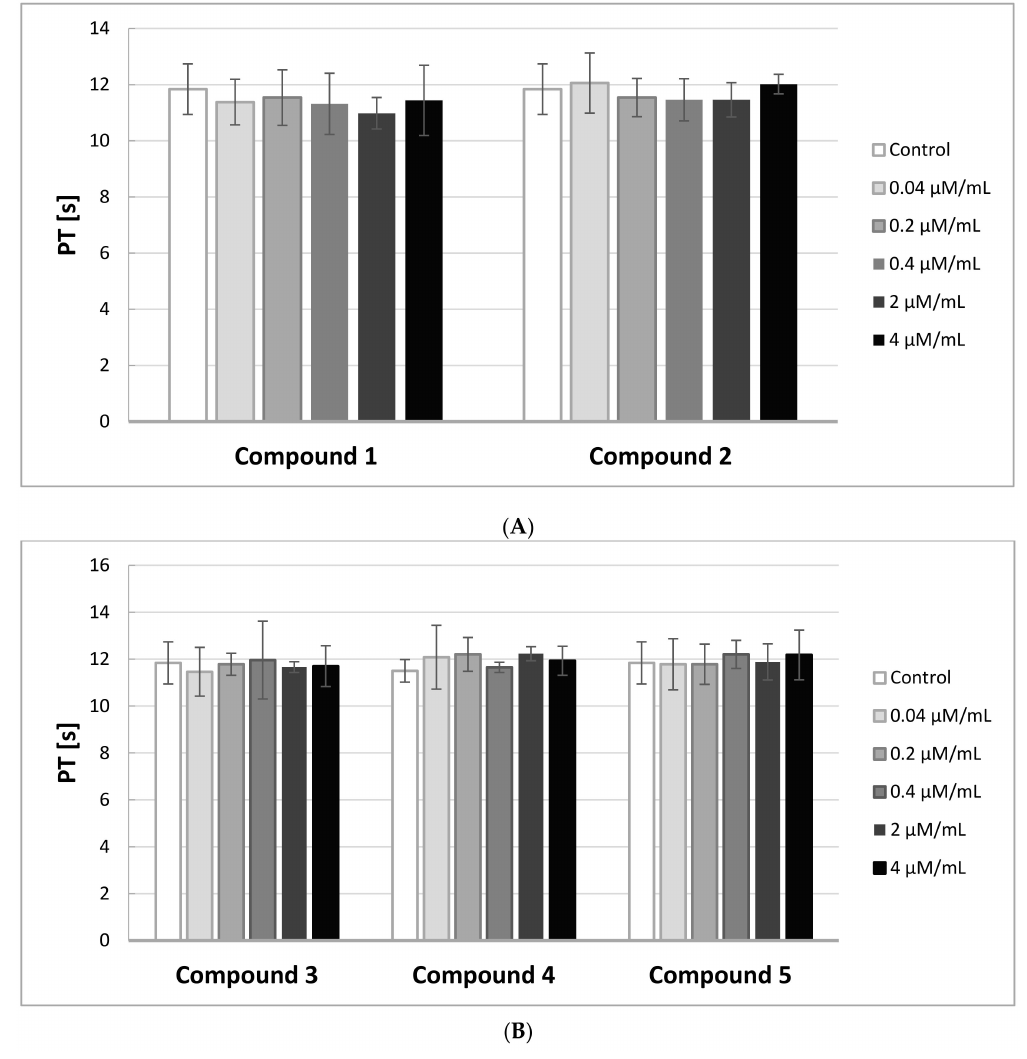
Figure 5. The effects of iminodiacetic acid derivatives ( A ) compounds 1 and 2 ; ( B ) compounds 3 – 5 on Prothrombin Time (PT) (mean ± SD; n = 5) after 3 min incubation in plasma; final volume 160 µ L. Iminodiacetic acid derivatives did not affect in a statistically significant way the values of PT in comparison with